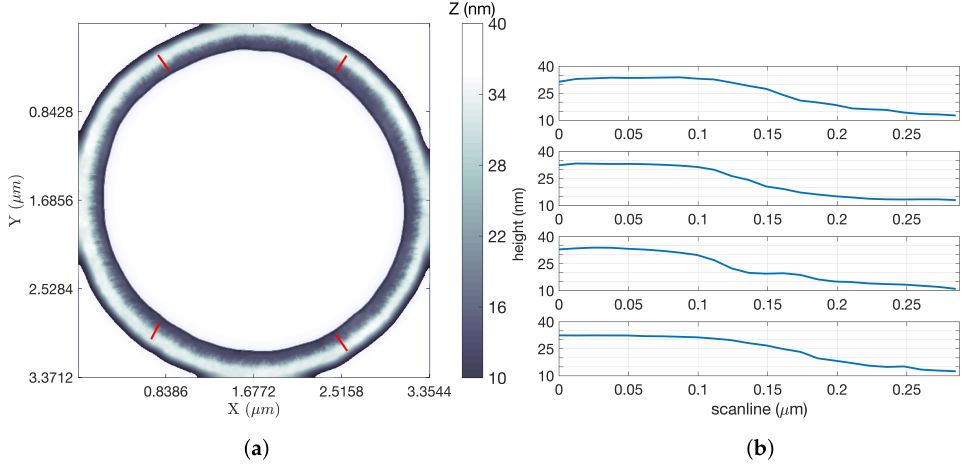
Figure 6. Circular grating results. ( a ) LCS image. The white background indicates no information (LCS z image, ω = 20 Hz); ( b ) Two hundred and ten nanometer-long (17 pixel) line scans generated from along each of the four red lines shown on the LCS image, starting from the top left and proceeding clockwise. All scans were directed outside to inside and are shown for the scans starting in the upper left and proceeding clockwise. Step heights were (from top line scan plot to bottom) 21.2, 20.4, 21.0 and 20.01 nm (line scans along red lines in ( a